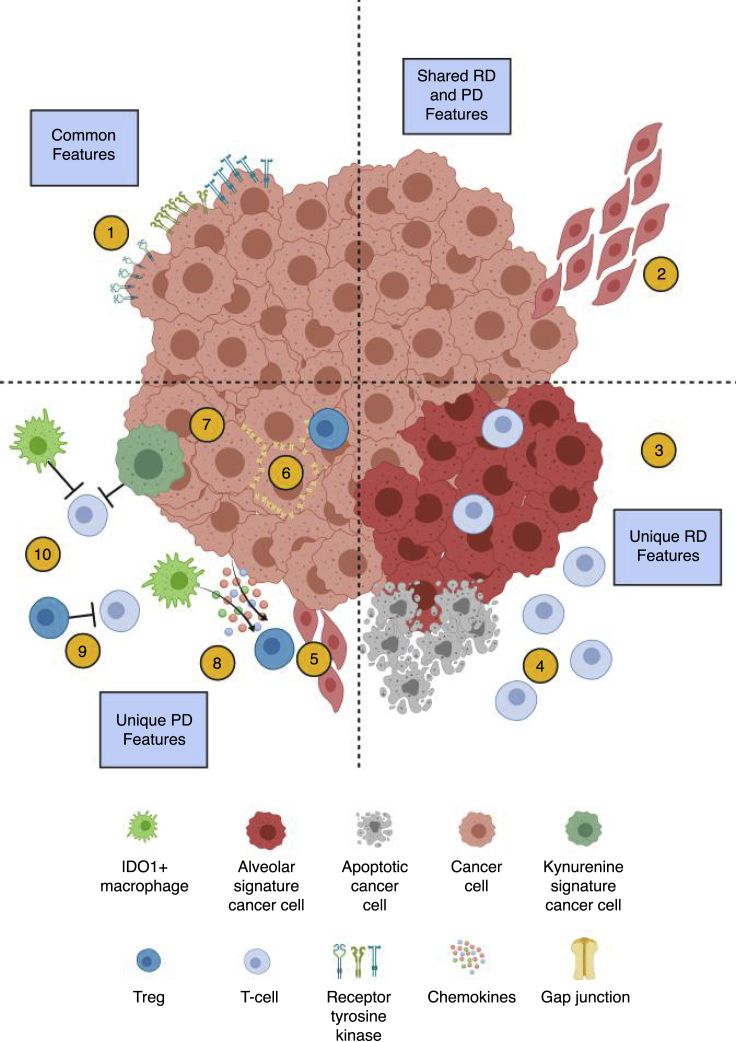
scRNA-seq Profiles Reveal Clinical-State Specific Features of the Tumor Cellular EcosystemFeatures common to all time points are shown in the top-left quadrant and include the presence of multiple oncogenic drivers (1). Features shared in RD and PD are shown in the top-right quadrant and include various invasive signaling pathways (2). Features unique at RD, shown in the bottom-right quadrant, include the Alveolar signature (3) and increased T cell fraction (4). Features unique to PD, shown in the bottom-left quadrant, include upregulation of the plasminogen activation pathway (5), expression of gap-junction proteins (6), loss of tumor suppressor genes (7), expression of pro-inflammatory chemokines (8), increased Treg population (9), and increased kynurenine signature expression (10).